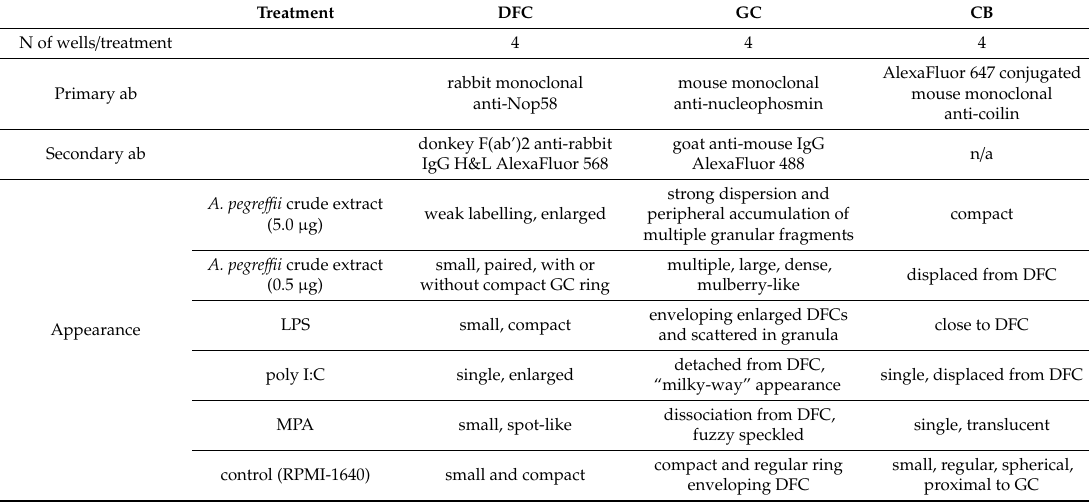
Table 1. Experimental design of the peripheral blood mononuclear cells (PBMC) immunocytochemistry (ICC) protocol developed in 24-well plates and morphological appearance of the cell nucleoli. Treatment